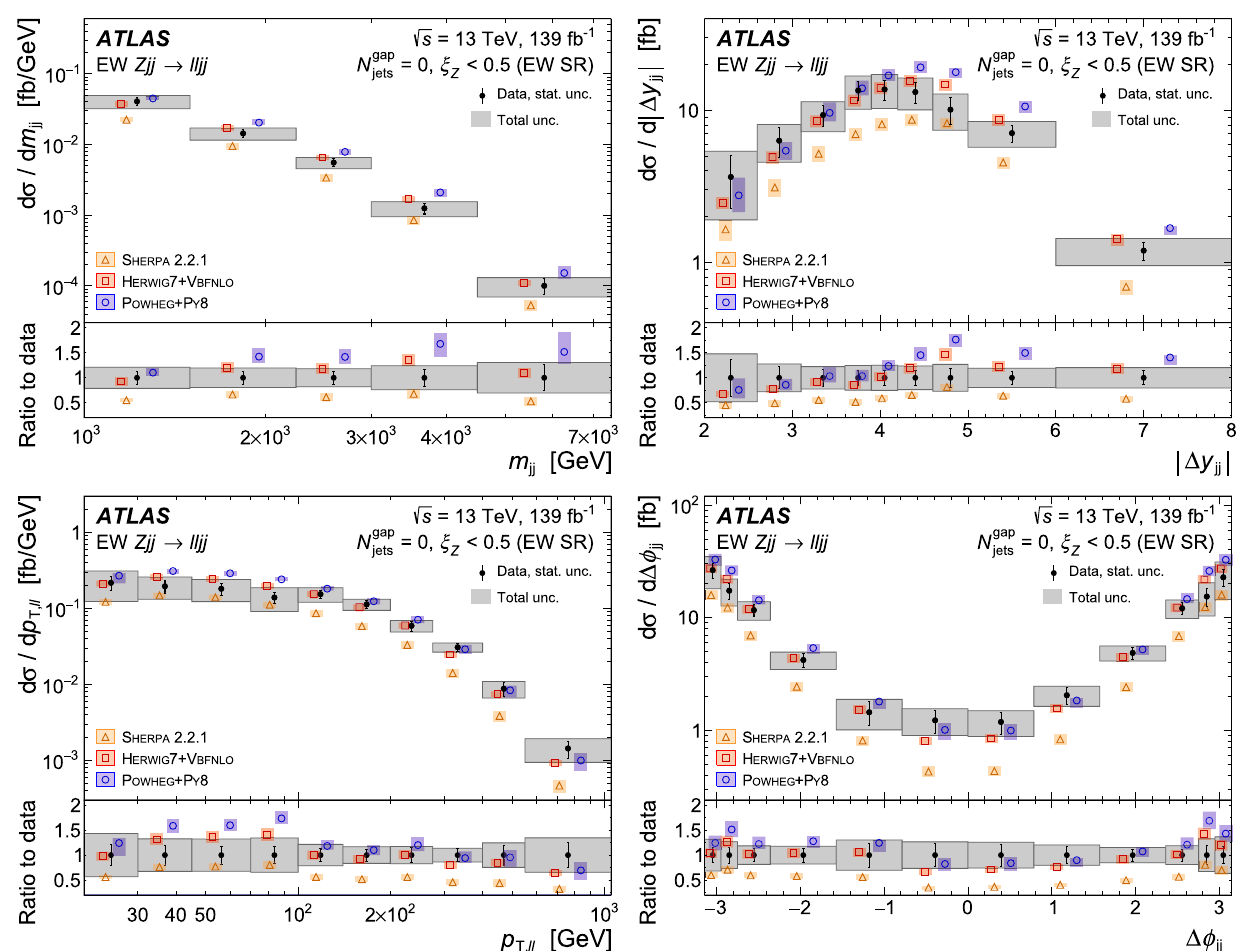
Fig. 7 Differential cross-sections for EW Zjj production as a function of m jj (top left), | (cid:4) y jj | (top right), p t ,(cid:3)(cid:3) (bottom left) and (cid:4)φ jj (bottom right). The unfolded data are shown as black points, with the statistical uncertainty represented by an error bar and the total uncertainty represented as a grey band. The data are compared with theoretical predictions produced by Herwig 7+ Vbfnlo (red points), Powheg + Py 8 (blue points) and Sherpa 2.2.1 (orange points). Uncertainty bands are shown for the three theoretical predictions. Each theory prediction is slightly offset from the bin center to avoid